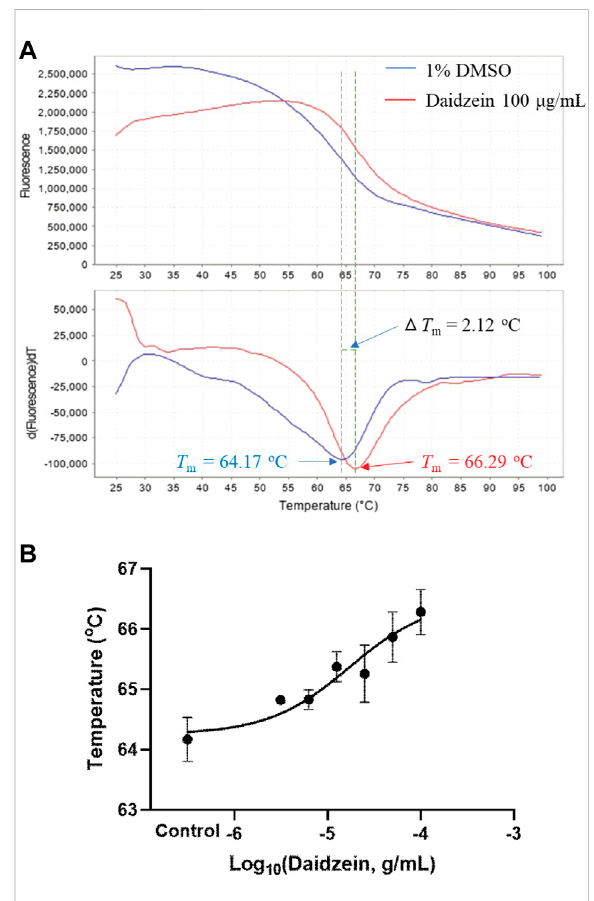
FIGURE 5 Ligand screening with the recombinant human M3 receptor protein as detected by thermal shift assay. (A) Representative fl uorescence melt curve (upper) and derivative melt curve (lower) containing mean melt temperatures ( T m) of the M3 receptor proteinwithorwithoutdaidzein(100 μ g/ml),showingthatbinding of daidzein increased the thermal stability of the M3 receptor protein with Δ T m > 2 ° C. (B) Daidzein (3.125 – 100 μ g/ml) concentration-dependently increased the melt temperatures of theM3receptorprotein.DataarepresentedasMean±SEM(n=3). DMSO (1%) served as the vehicle control.